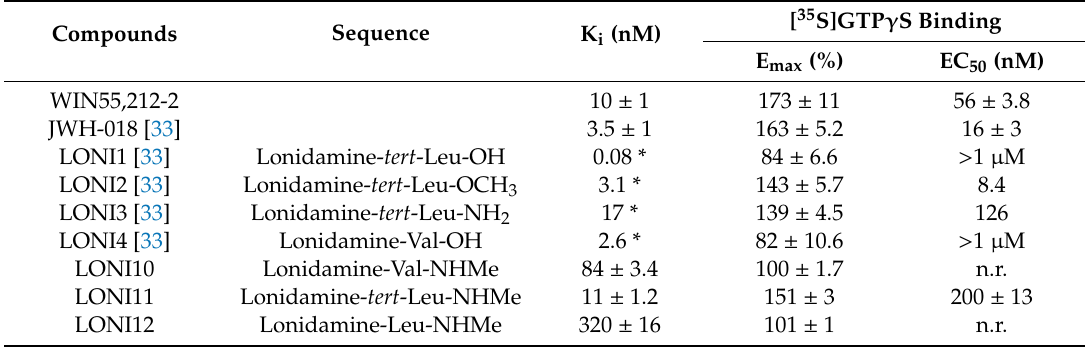
Table 1. Binding a ffi nity (K i ) and signal properties e ffi cacy (E max ) and potency (EC 50 ) of lonidamine-based compounds.